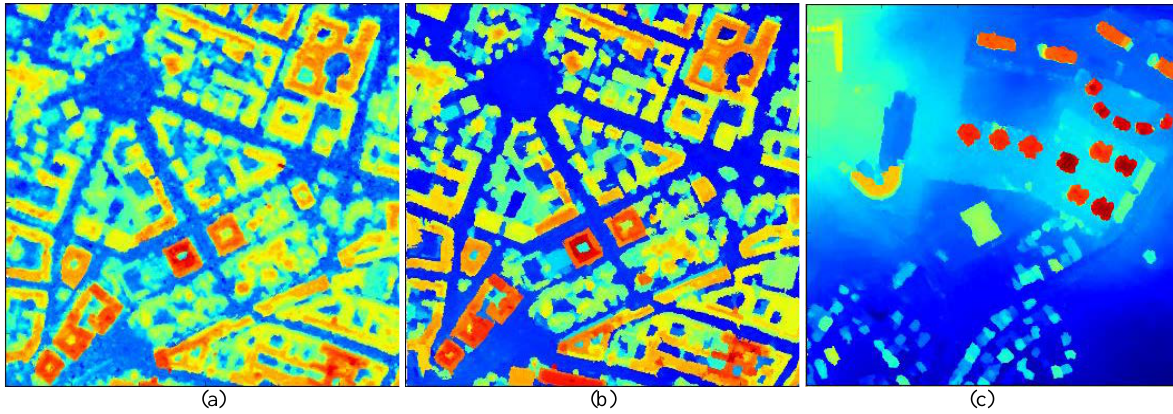
Figure 8. Results, filled DSMs; (a) Istanbul, WV2, (b) Munich, WV2, Munich, (c)